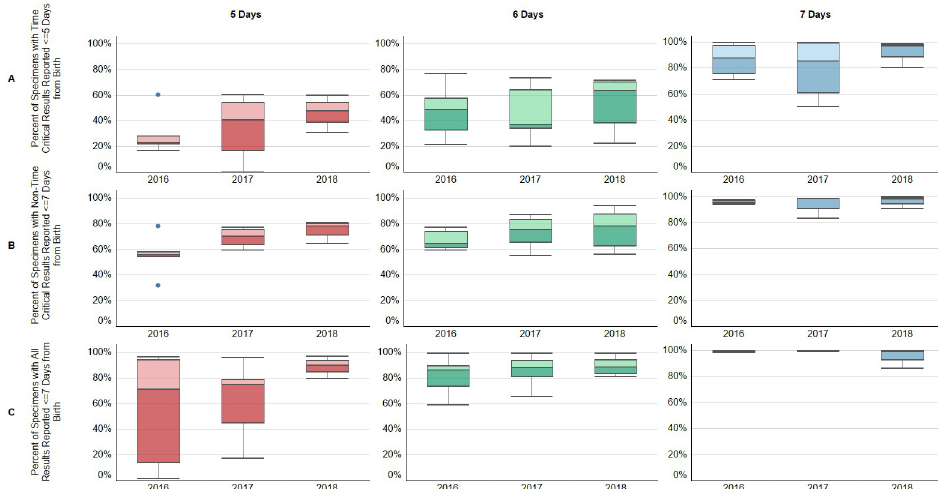
Fig 4. Newborn screening programs that are open seven days report a higher percentage of results to medical providers in the recommended time period. Box and whisker plots display the median of the percent of specimens that met the benchmark for each program, with upper and lower quartiles, and range. Panel A: Percent of specimens with results reported out for time-critical results within five days of life at programs open five days (left), six days a week (middle) and seven days a week (right). Panel B: Percent of specimens with results reported for non-time-critical results within seven days of life at programs open five days (left), six days a week (middle) and seven days a week (right). Panel C: Percent of specimens with all results reported within seven days of life at programs open five days (left), six days a week (middle) and seven days a week